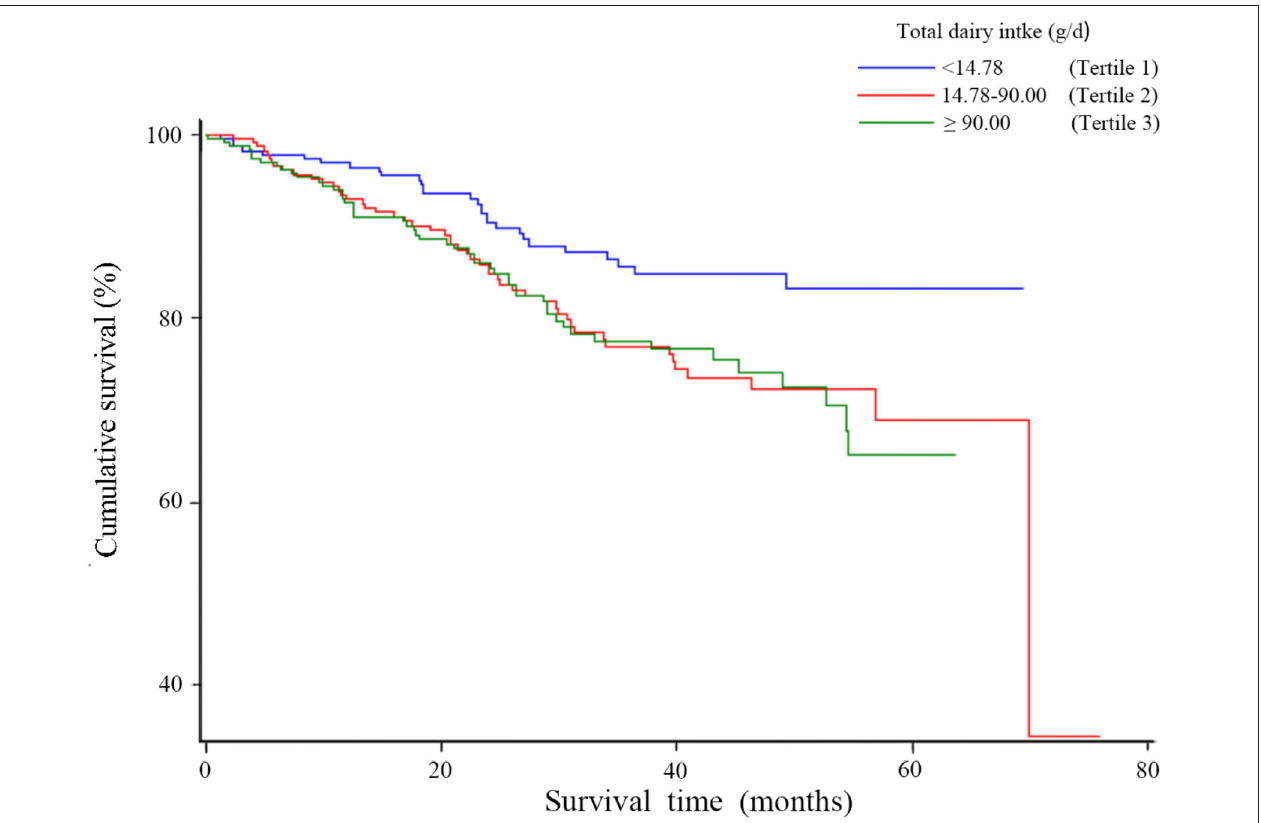
FIGURE 2 | Kaplan-Meier survival curves for total dairy productions consumption.